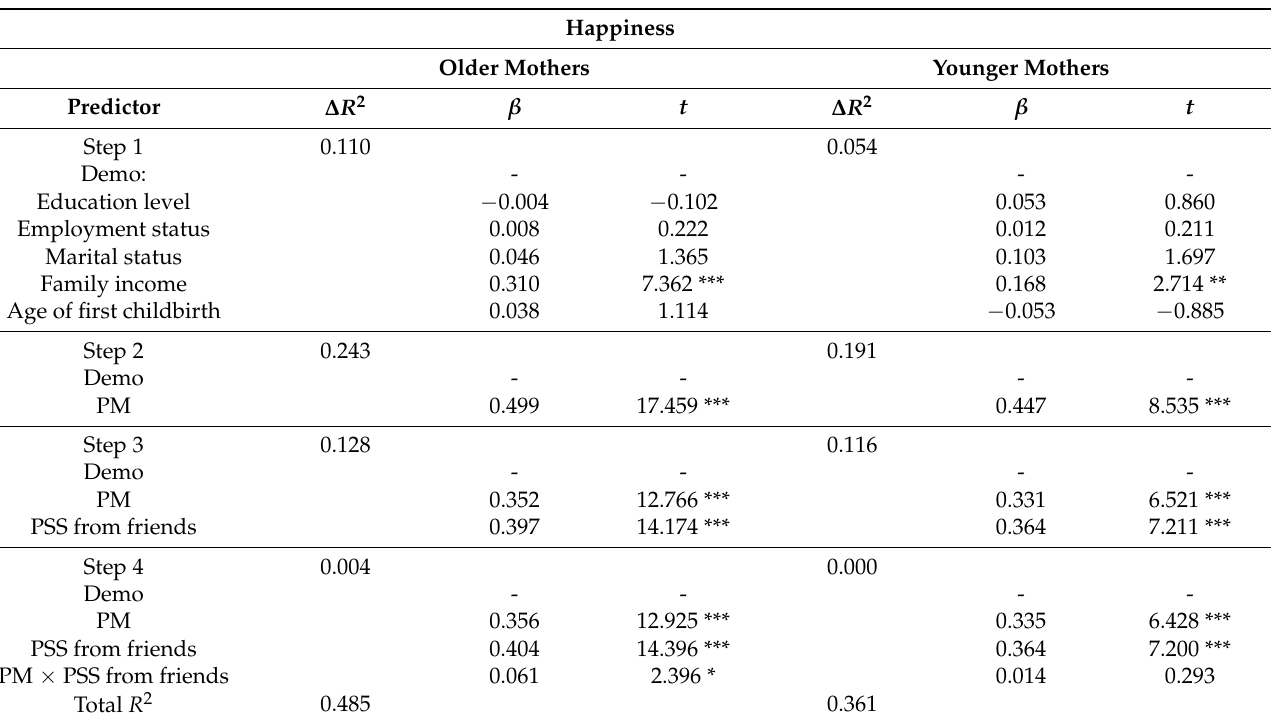
Table 6. Hierarchical regression analyses predicting happiness from presence of meaning in moth- erhood and perceived social support from friends among older ( n = 819) and younger mothers ( n = 295). Happiness Older Mothers Younger